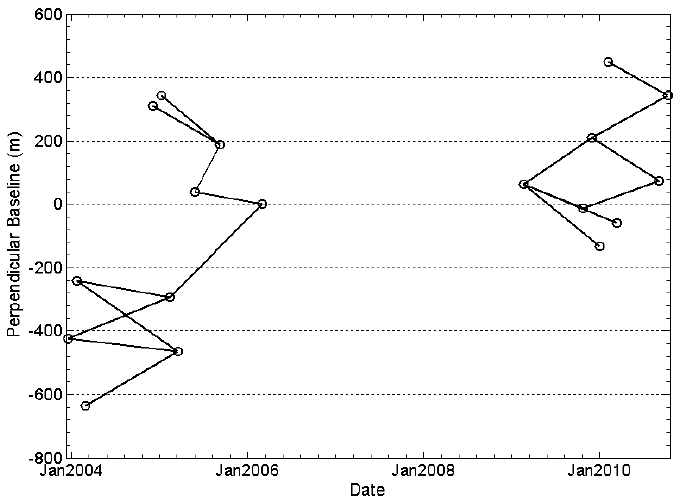
Figure 9. Configurations of InSAR pairs used for the abnormal deformation monitoring. Remote Sens. 2016 , 8 , 284